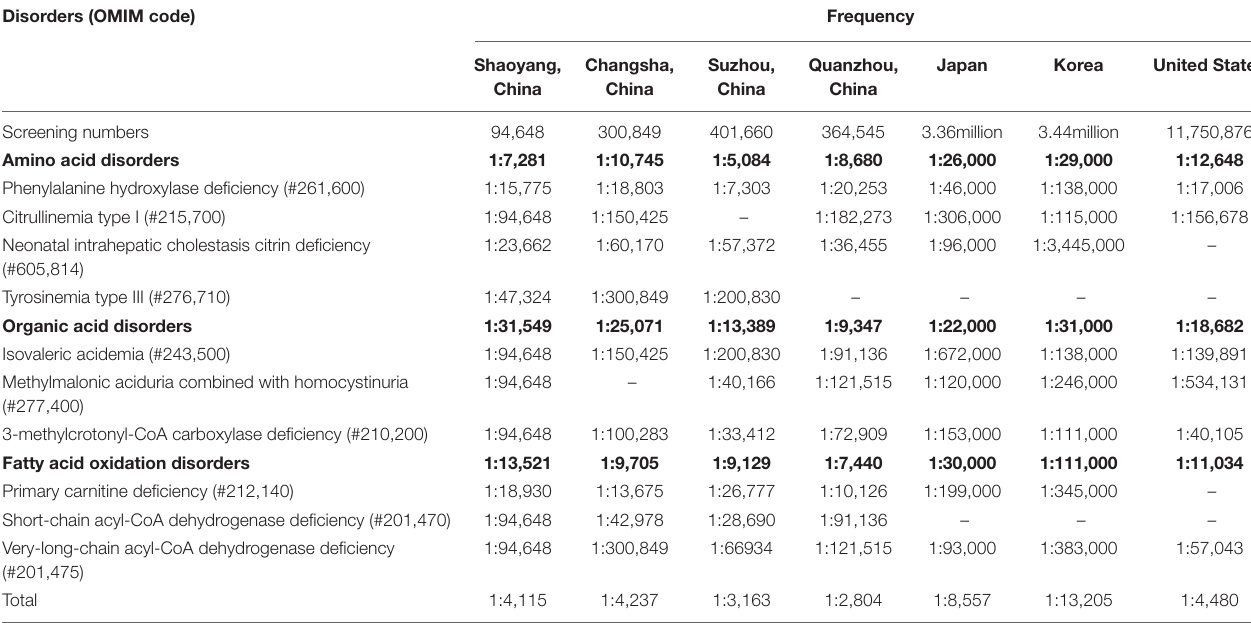
TABLE 6 | The incidence of different regions and